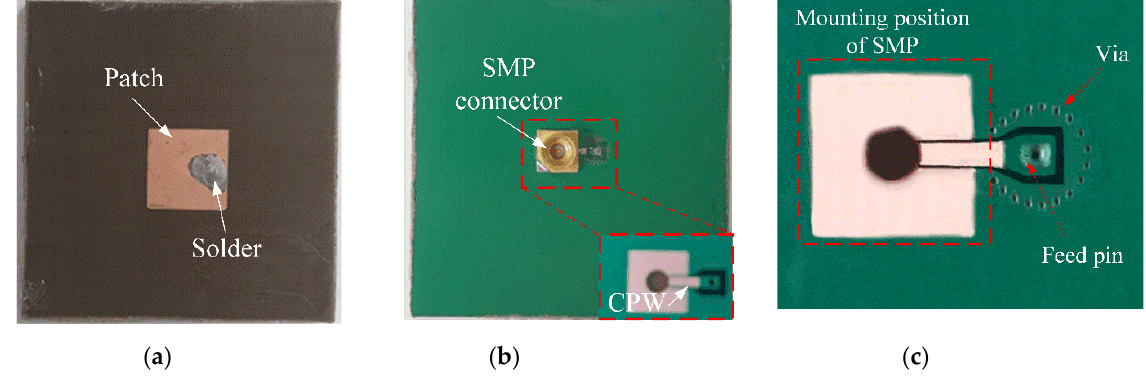
Figure 2. Photograph of the proposed antenna: ( a ) top view; ( b ) bottom view, ( c ) zoomed CPW. Figure 3 shows the measured (solid line) and simulated (dashed line) reflection coef ‐ ficients of the proposed antenna. The measured reflection coefficient is observed to be − 27 dB at 10 GHz, which is in good agreement with the simulated result of − 20.9 dB. In addi ‐ tion, the measured fractional bandwidth (| Γ | < − 10 dB) is 4.7% (9.82~10.29 GHz), and that of the simulation is 3.3% (9.84~10.17 GHz). Thus, the proposed antenna can be applied to the X ‐ band radar applications.